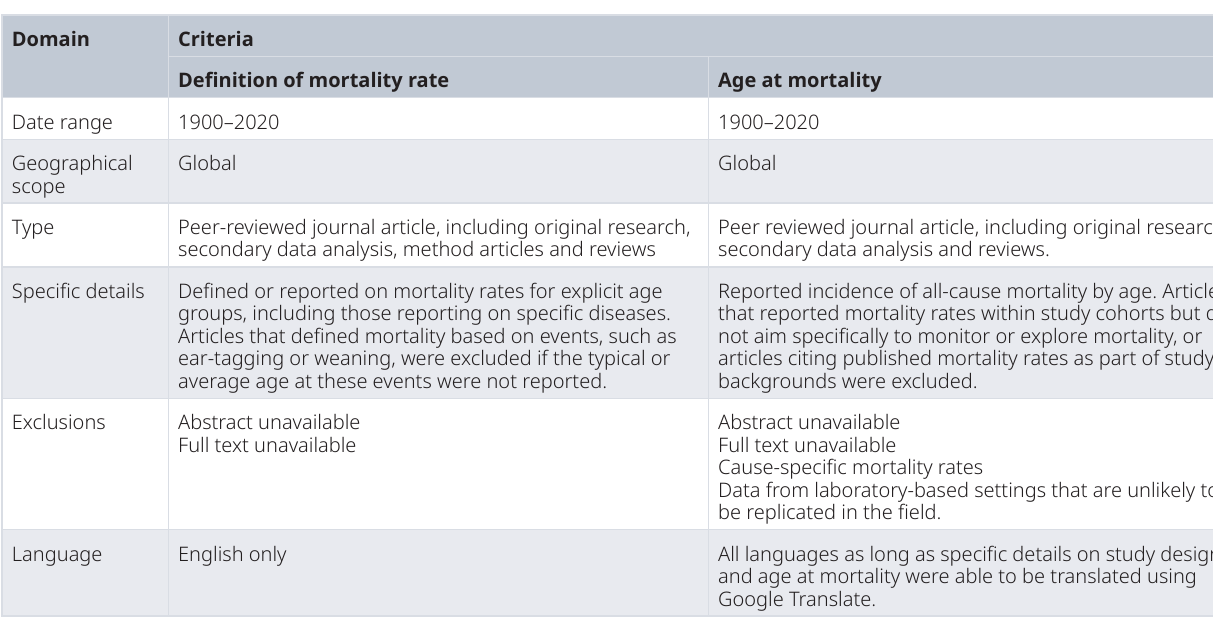
Table 4. Study selection